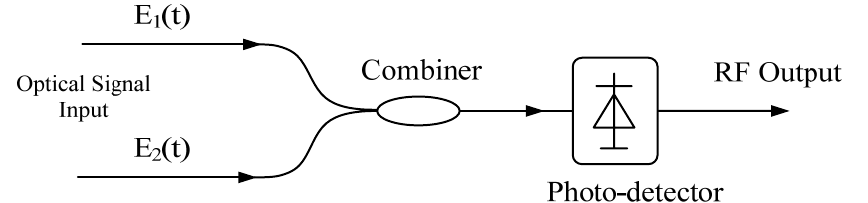
Figure 12. The schematic diagram for microwave generation by beating two different wavelengths.